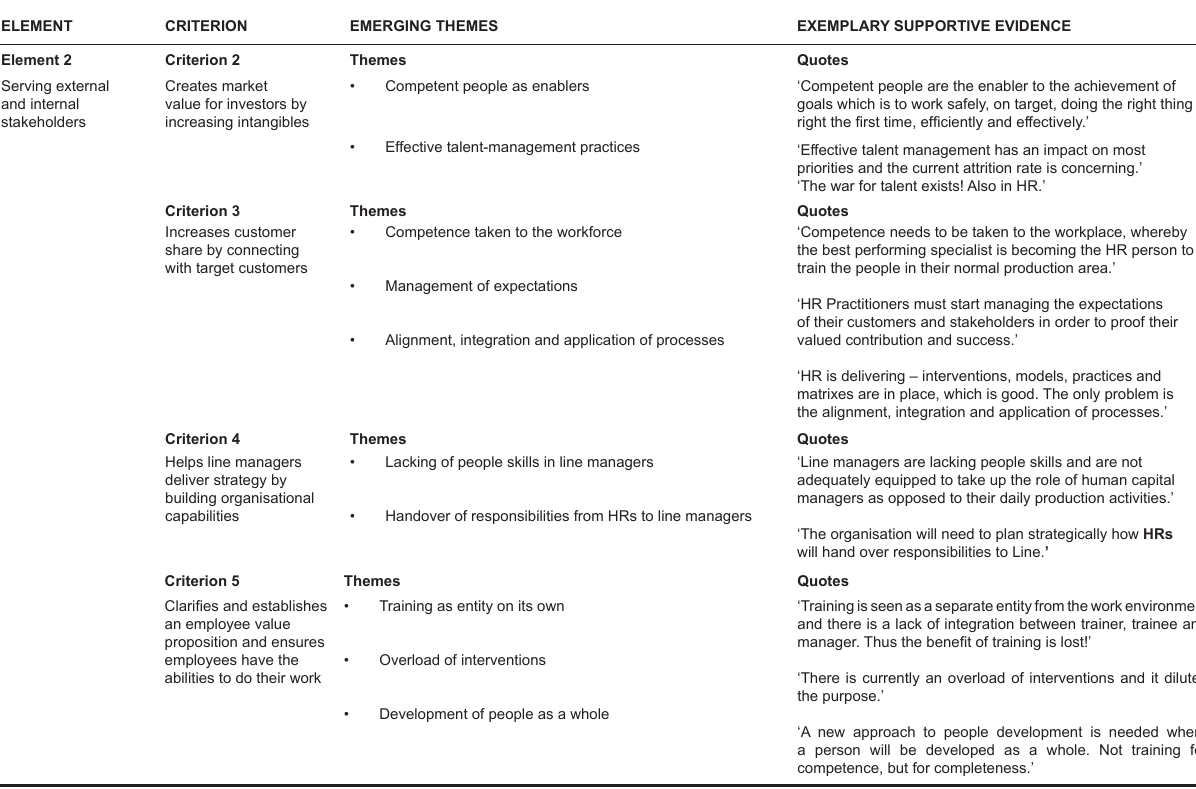
TABLE 3 Emerging themes pertaining to Element 2: Serving external and internal